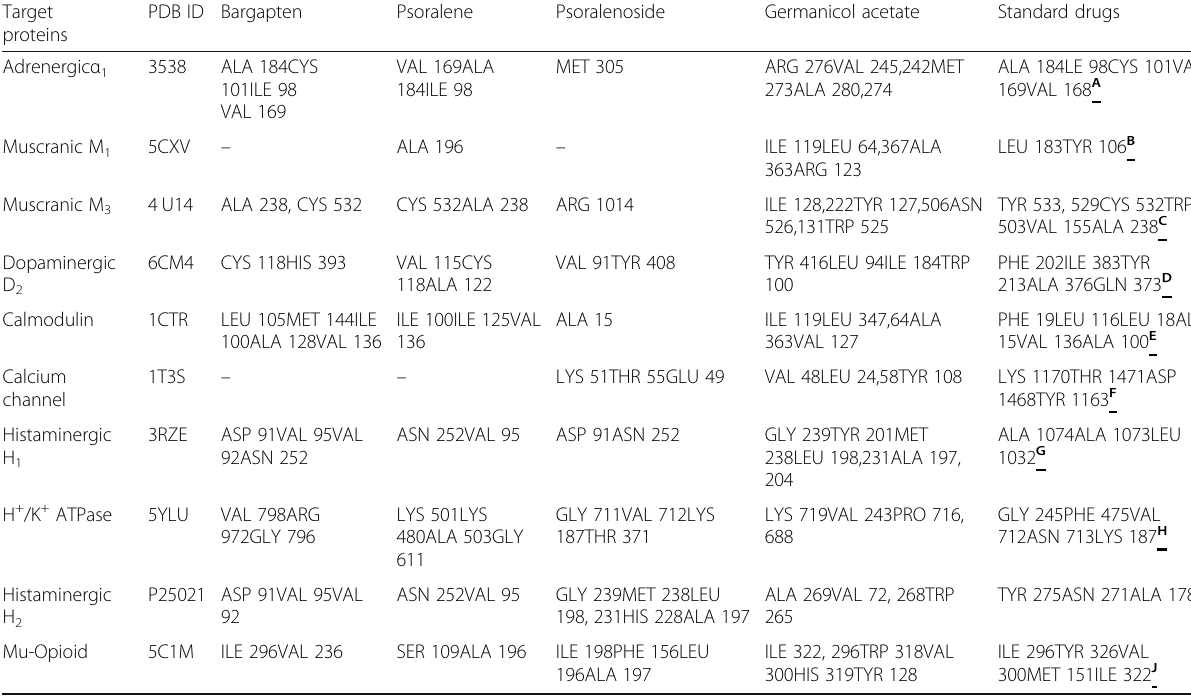
Table 7 Hydrophobic interactions formed by bergapten, psoralene, psorelenoside, germanicol acetate and standard drugs against targets: adrenergic α 1 receptor, muscranic M 1 , muscranic M 3 , dopaminergic D 2 , calmodulin, mu-opioid, voltage gated L-Type calcium channel, histaminergic H 1 , histamergic H 2 and H + /K + ATPase